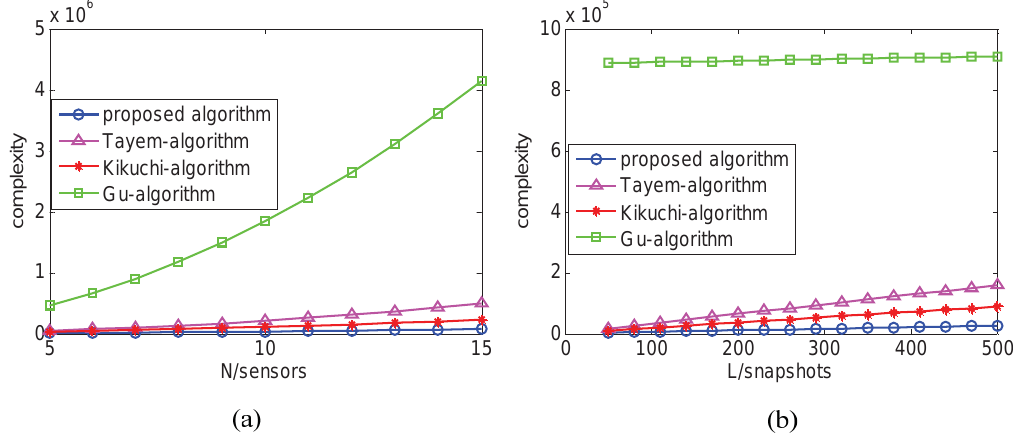
Figure 2. ( a ) Complexity comparison versus sensors; and ( b ) complexity comparison versus